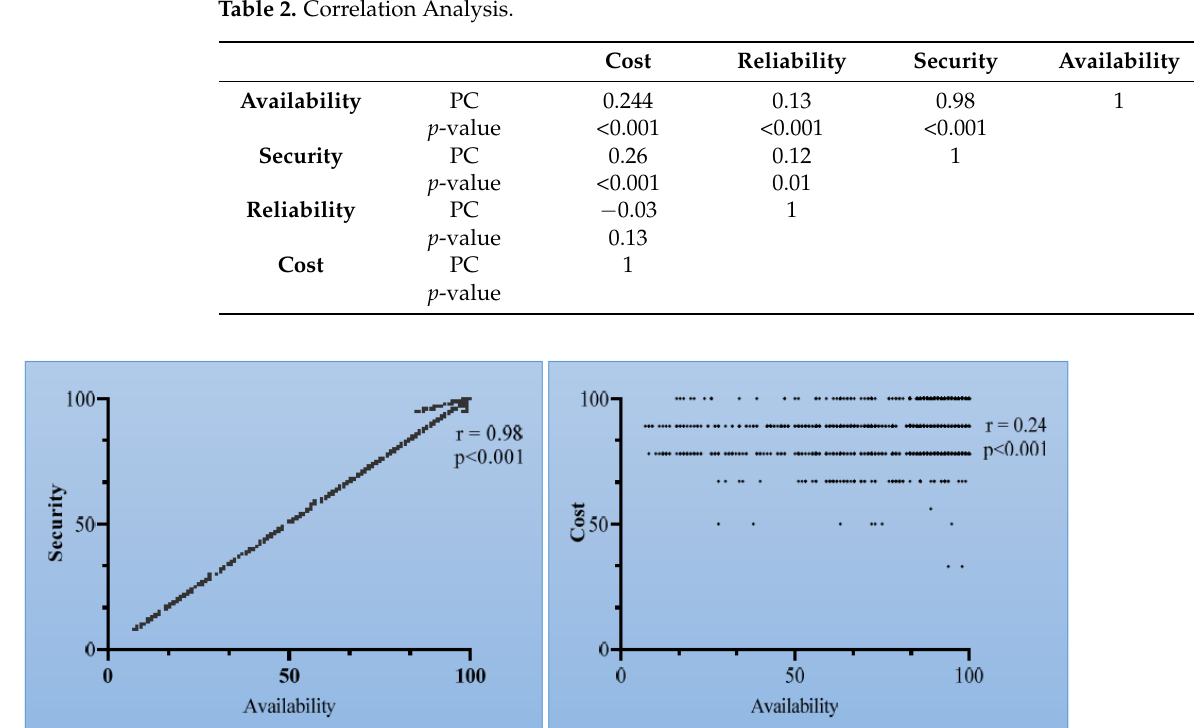
Figure 7. Correlation analyses among identified parameters using end- users’ feedback . 5.1. Cloud-Service Ranking 5.1.1. Sequential Minimal Optimization Regression (SMOreg) The SMOreg scheme is employed to rank cloud services based on the identified at- tributes. SVM for regression is implemented in SMOreg. The parameters are learnable through a variety of methods. The focus of the SMOreg is cloud-service ranking for com- petitiveness prediction. The RegOptimizer controls which algorithm is used. SMOreg used a dataset: {(x 1 , y 1 ), ... ,(x n , y n )}, where x i are input vectors and y i are the scalar target outputs denoting ranking classes (R 1 , R 2 , …, R 7 ). The two-layer architecture contains an input layer of four inputs. Then, there are a total of seven SVMs in SMOreg dented by S g , each one learning to extract one latent variable f(x| l ) g from an input pattern x. Here l de- notes the trainable parameters in the hidden-layer SVMs. Finally, there is the main SVM in SMOreg denoted by M g that learns to approximate the target function using the ex- tracted feature vector as an input. The total number of correct instances divided by the total number of instances provides the accuracy of the anticipated model SMOreg. This technique is only applicable if the amount of labeled data is insufficient or if application or device-specific solutions are required to improve the accuracy of detection. Table 3 shows an optimized SMOreg characterization for cloud-service classification. The accu- racy rate obtained is 98.71 per cent. The prediction speed was roughly 110 observations per second, and the training time was 3.138 s. We made a comparison of two of the most widely used and well-known algorithms versus multiclass classification (i.e., the MLP and LR).